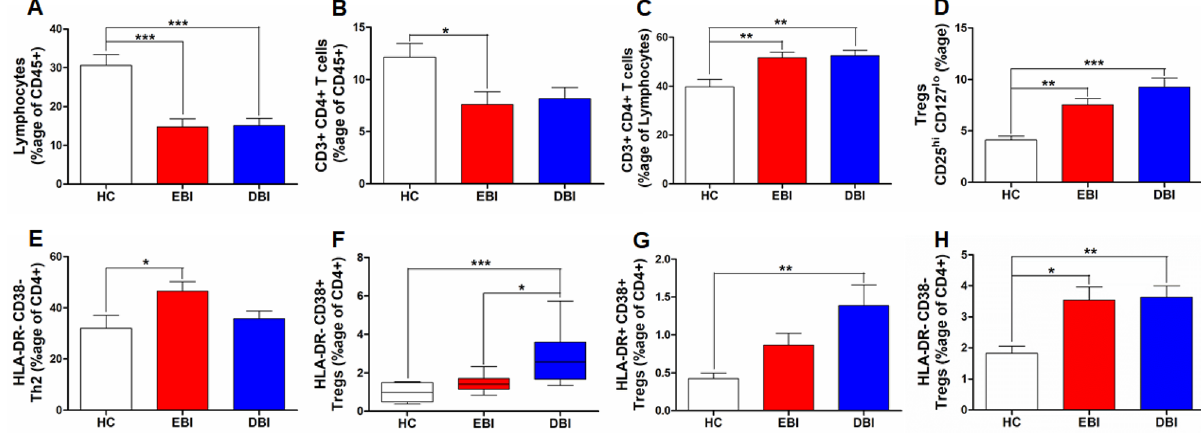
Figure 1. Comparison of peripheral blood: ( A ) lymphocytes (low SSC and high CD45 expressing cells) after SAH during EBI and DBI phases with healthy controls; ( B ) CD4+ T cells (expressed as %age of CD45 + leukocytes) after SAH during EBI and DBI phases with healthy controls; ( C ) CD4+ T cells (expressed as %age of lymphocytes) after SAH during EBI and DBI phases with healthy controls; ( D ) Tregs (CD25 hi CD127 lo , expressed as %age of CD3+ CD4+ T cells) after SAH during EBI and DBI phases with healthy controls; ( E ) HLA-DR− CD38− Th2 cells (expressed as %age of CD3+ CD4+ T cells) after SAH during EBI and DBI phases with healthy controls; ( F ) HLA-DR− CD38+ Tregs (expressed as %age of CD3+ CD4+ T cells) after SAH during EBI and DBI phases with healthy controls; ( G ) HLA-DR+ CD38+ Tregs (expressed as %age of CD3+ CD4+ T cells) after SAH compared to healthy controls during EBI and DBI phases, ( H ) HLA-DR− CD38− Tregs (expressed as %age of CD3+ CD4+ T cells) after SAH during EBI and DBI phases compared to healthy controls. One way ANOVA followed by Tukey’s multiple comparisons test for normally distributed data. Kruskal Wallis test followed by Dunn’s multiple comparisons test for non-normally distributed data; A p value < 0.05 was considered as a significant difference. *Indicates a p value < 0.05, **indicates a p value < 0.01, ***indicates a p value < 0.001. HC healthy controls (n = 10), EBI early brain injury phase after SAH covering days 1–3 (n = 15), DBI delayed brain injury phase after SAH covering days 7–9 (n =